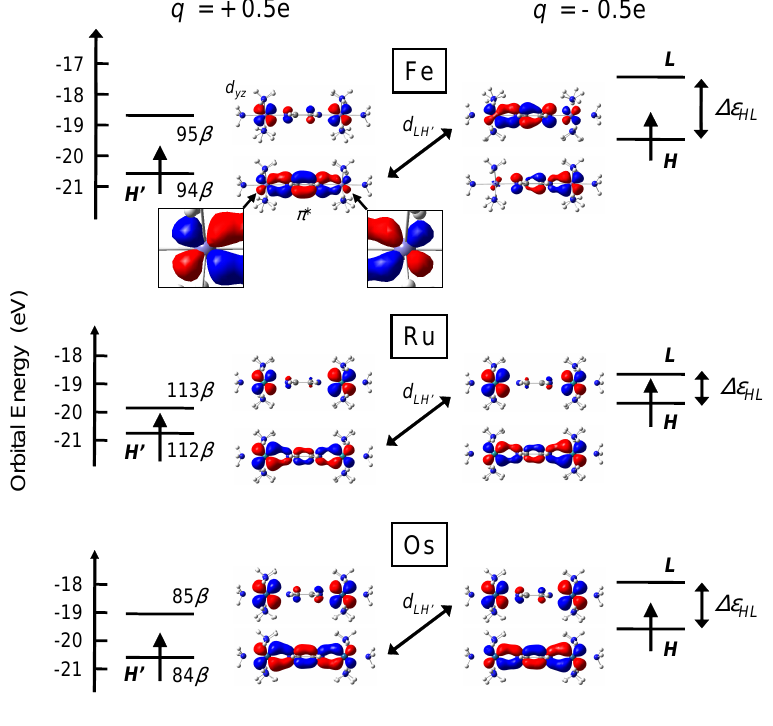
Figure 4. HOMO and LUMO with β spin of py complex when q = +0 . 5 e (left) and q = − 0 . 5 e (right).